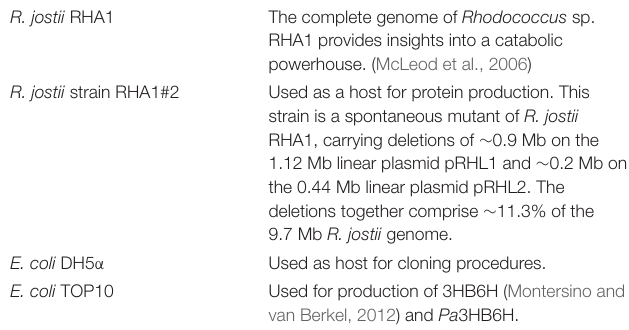
TABLE 2 | List of bacterial